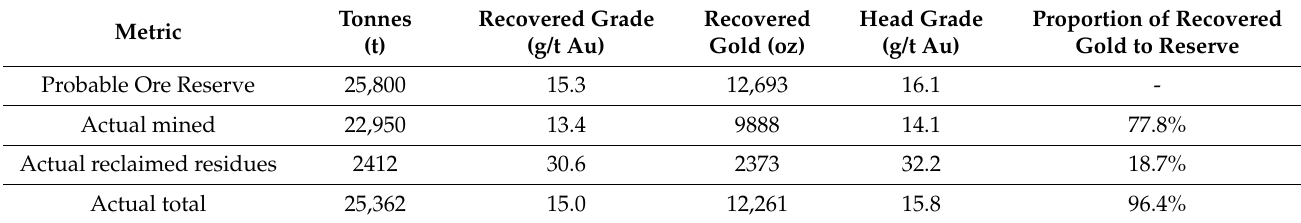
Table 14. Reconciliation between the actual extracted and the original residues models for the entire South Vein area. Actual mined based on reconciliation of gold produced from plant and tailings samples. Actual reclaimed residues based on reconciliation of gold produced from pilot plant and tailings samples. Ore reserve head grade based on grade control drilling. Figures may not compute due to